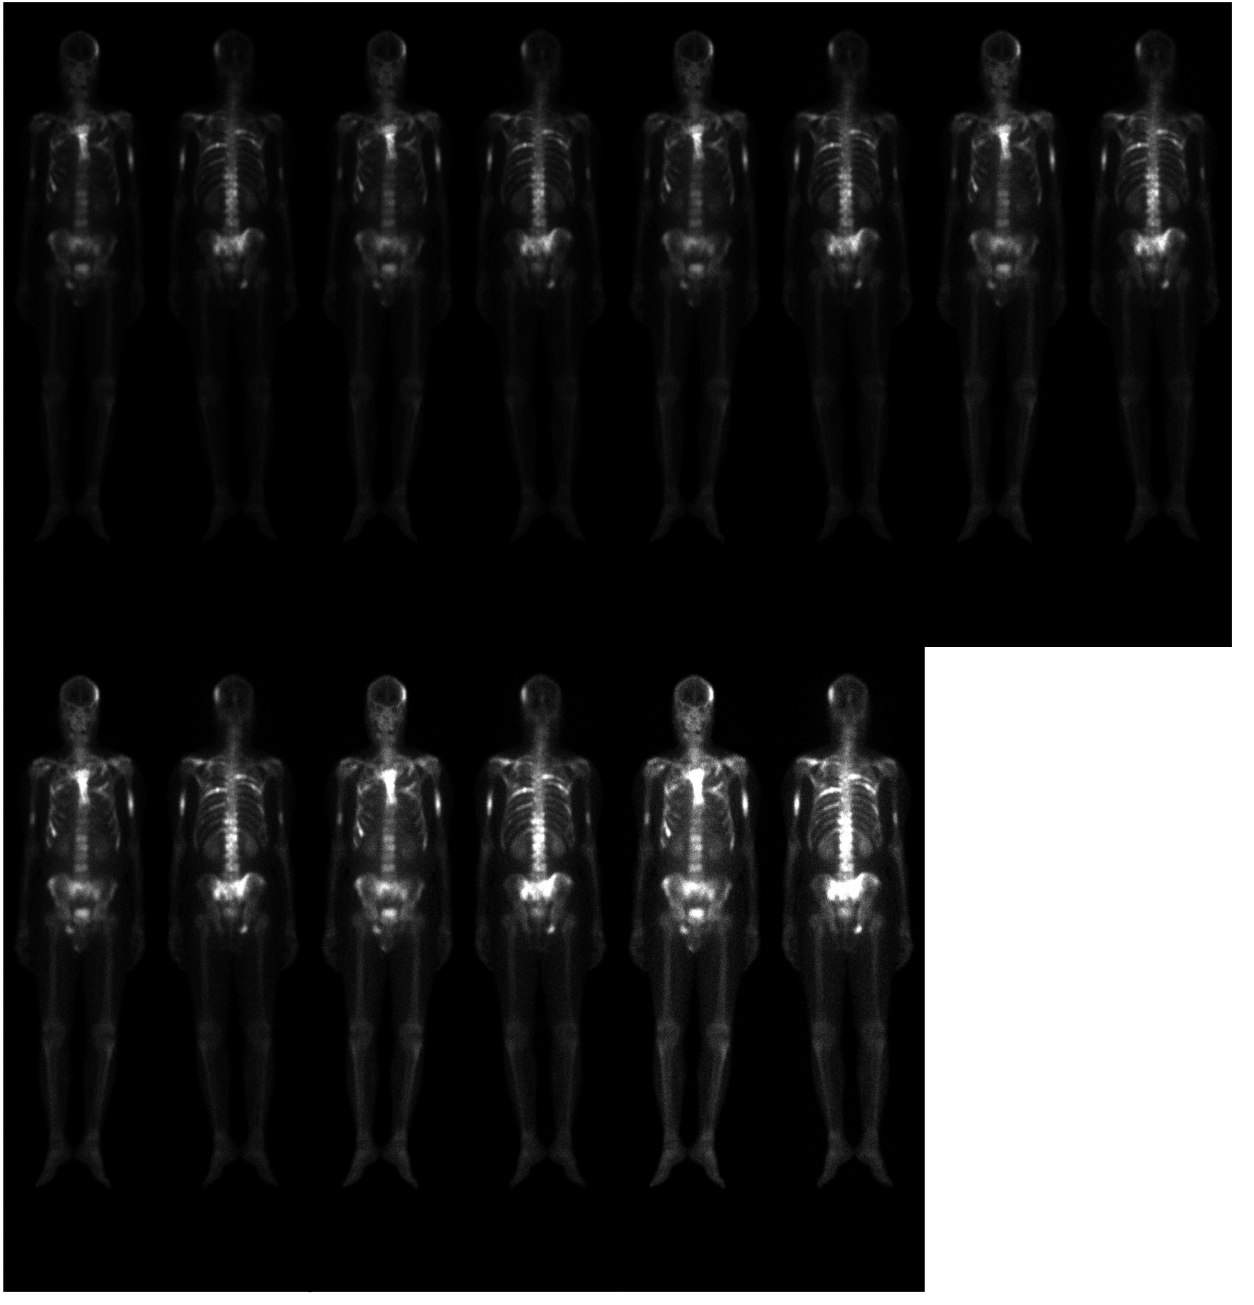
Figure 8. The 7 different contrast-level images were created for data augmentation